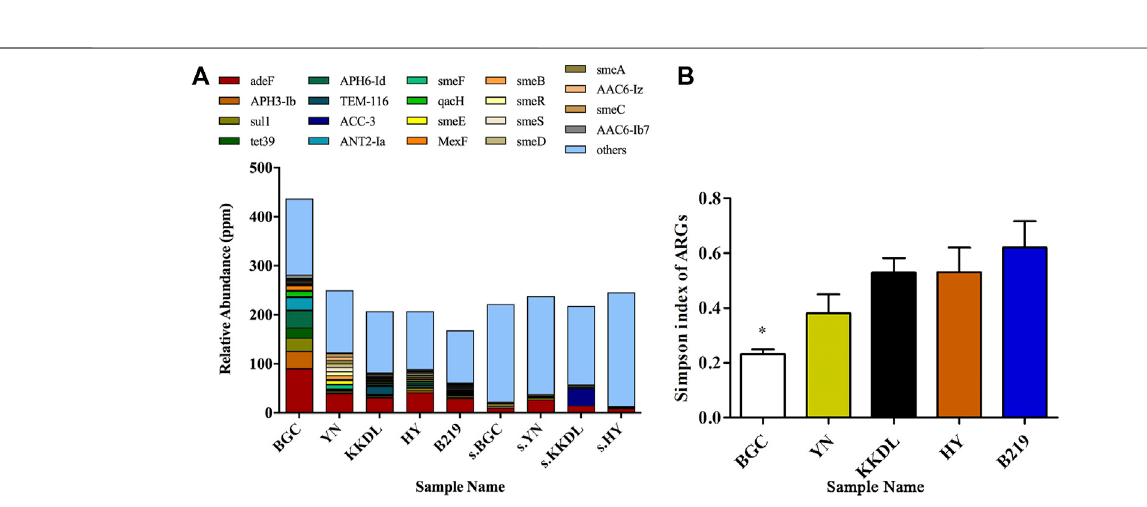
FIGURE 5 | Diversity and relative abundance of ARGs. (A) Diversity analysis of ARGs in all water samples; (B) relative abundance of ARGs of top 20.